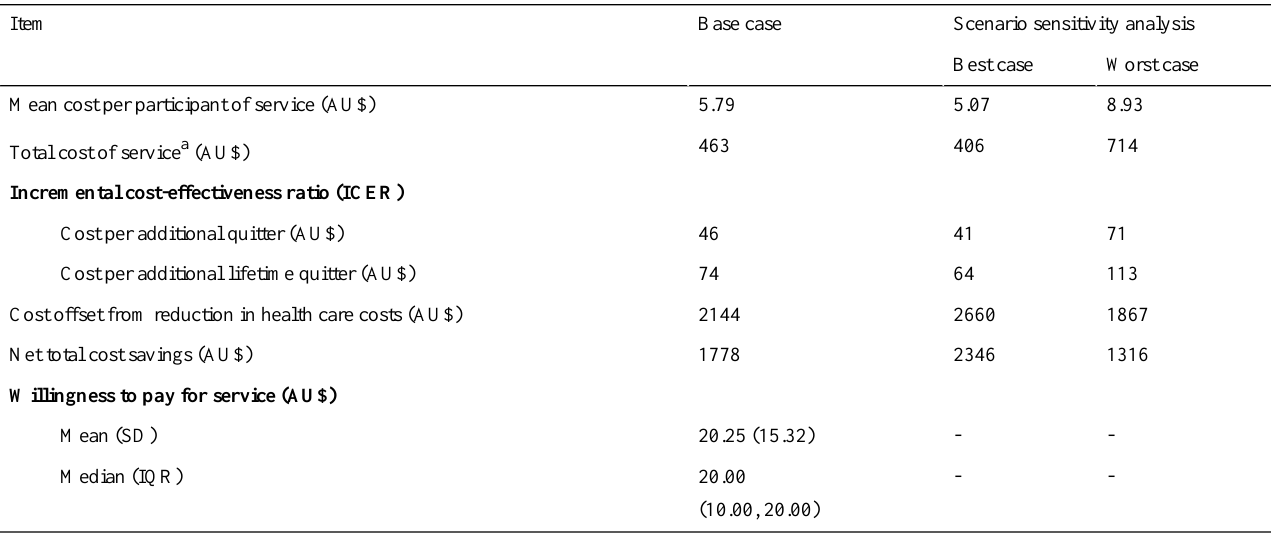
Table 4. Economic analysis of photoaging